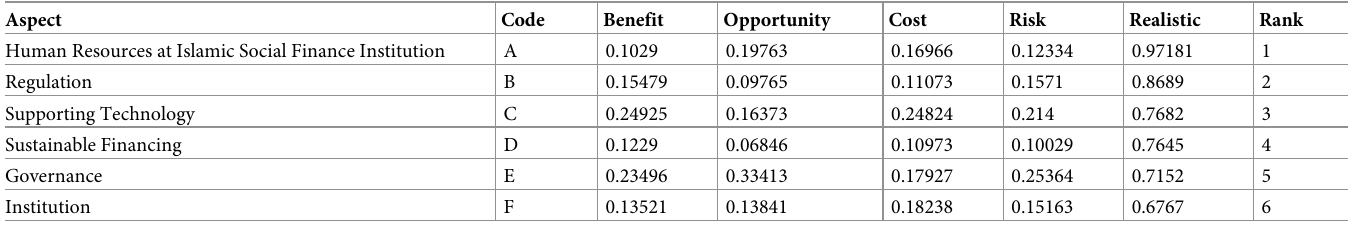
Table 3. ANP BOCR result of priority